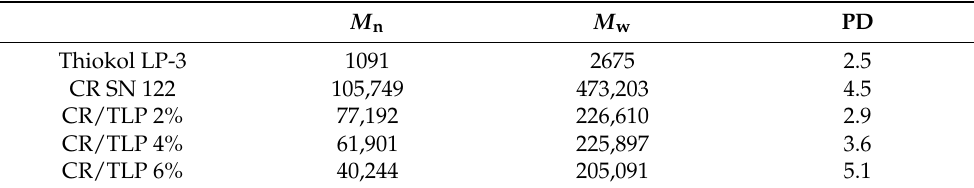
Table 3. Values of M n , M w and PD obtained from GPC data elaboration.